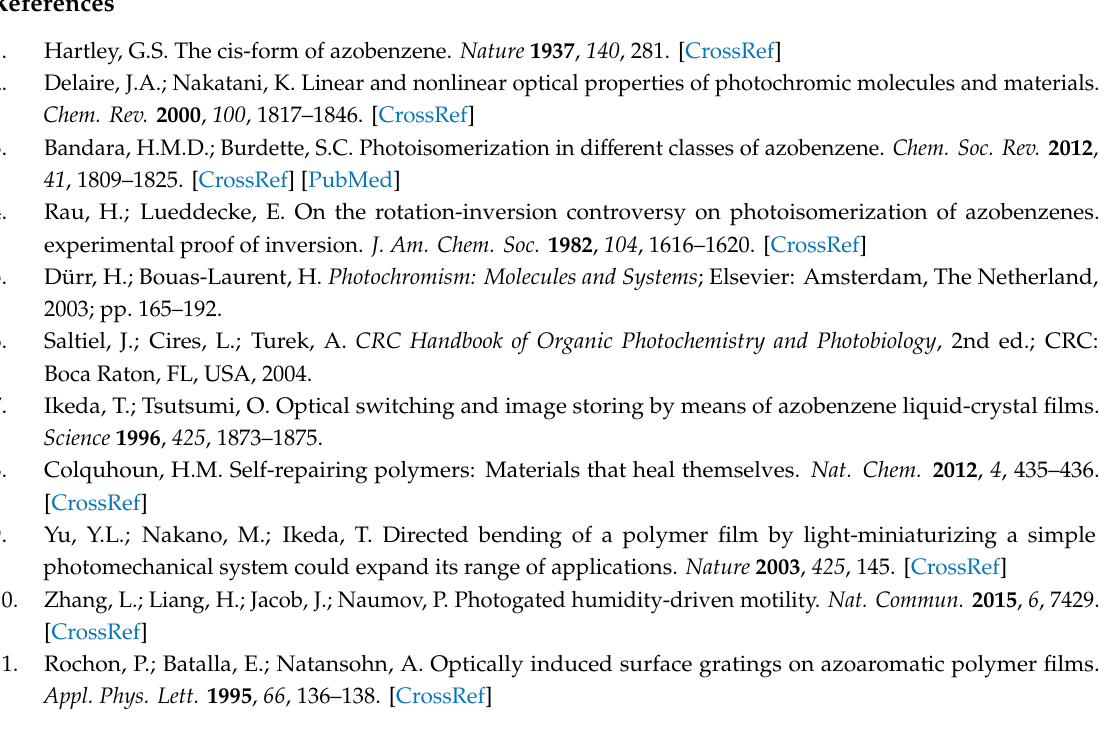
Figure S1: Scheme for synthesis of monomer M-1-Azo, Figure S2: Scheme for synthesis of monomer M-2-Azo, Figure S3: Scheme for synthesis of monomer M-3-Azo, Figure S4: Scheme for synthesis of monomer M-4-Azo, Figure S5: Scheme for synthesis of monomer